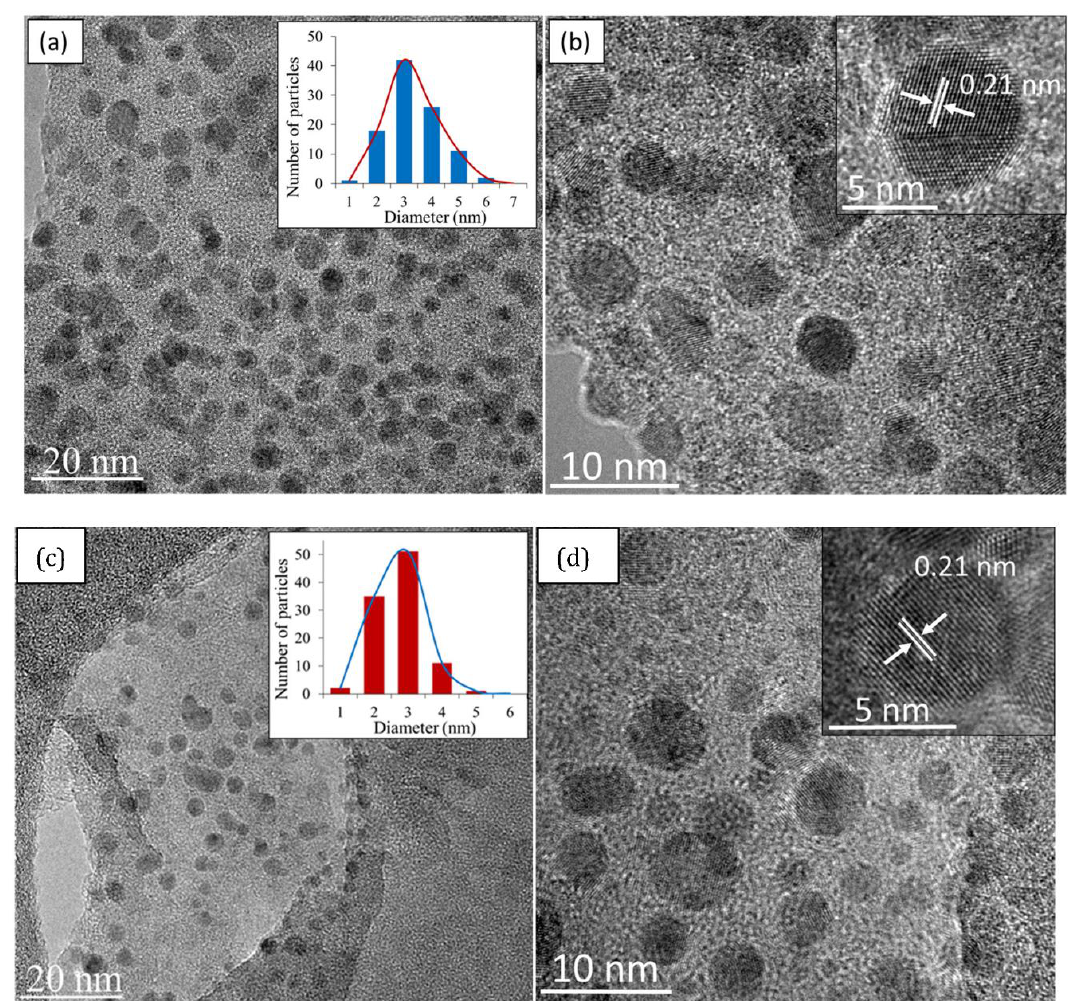
Figure 6. High-resolution transmission electron microscopy (HRTEM) images of ( a ) low magnification (inset: size distribution) and ( b ) high magnification of CQD (inset: lattice spacing); ( c ) low magnification (inset: size distribution) and ( d ) high magnification of EFB biochar (inset: lattice spacing).